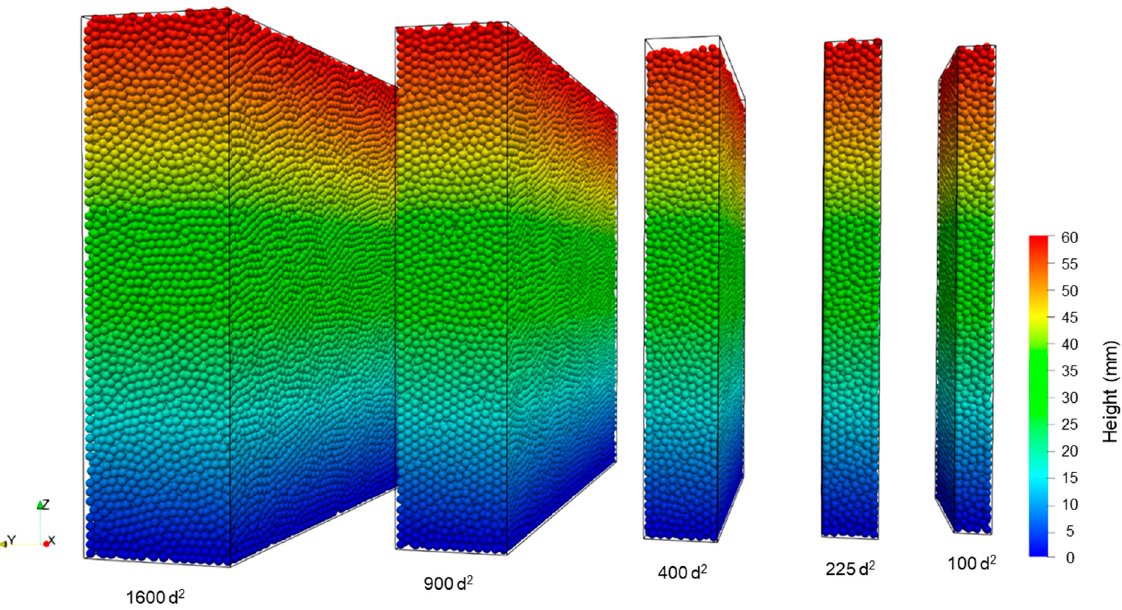
Figure 4. Rectangular pebble beds with an aspect ratio of 5 and cross-sectional areas of 100 d 2 –1600 d 2 .